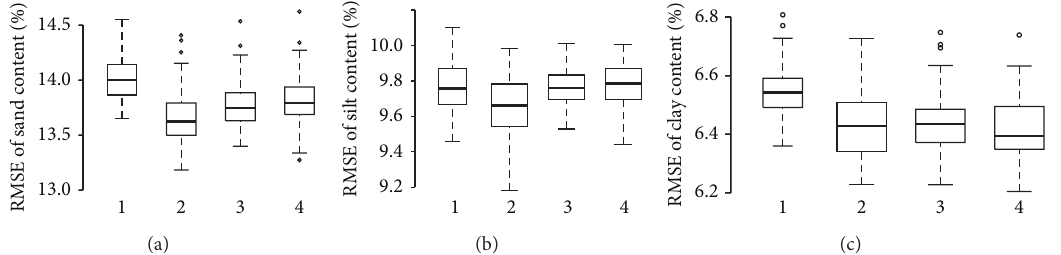
Figure 6: Cross-validated prediction error distributions as RMSE of the four boosting procedures.